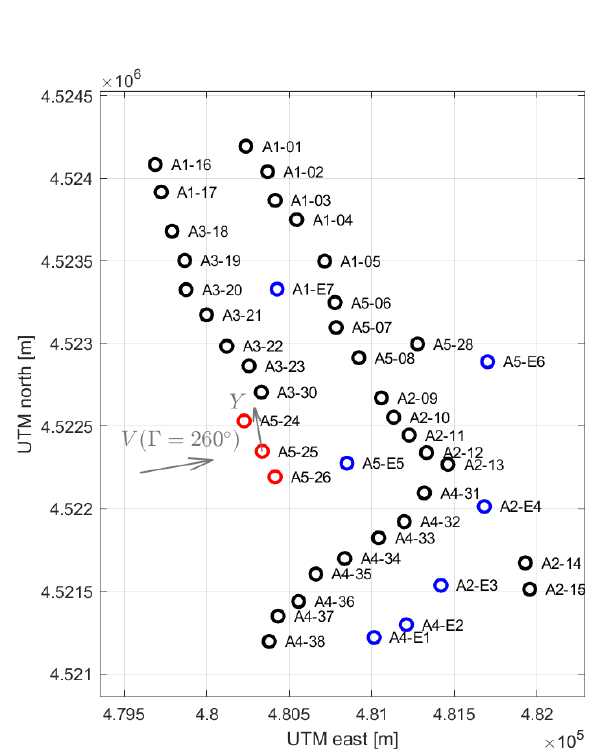
Figure 12. Top view of the Sedini wind farm with turbine identi- fiers. The gray arrows indicate the x and y axes for an ambient wind direction (cid:48) = 260 ◦